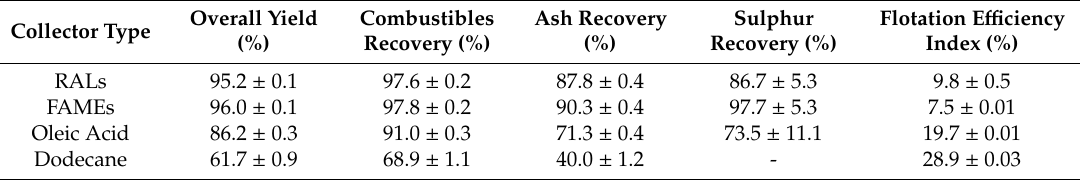
Table 3. Performance results from Site 2 batch flotation experiments using RALs and FAMEs compared to oleic acid and dodecane controls at a fixed dosage of 2.79 kg / t and at pH 2.7.